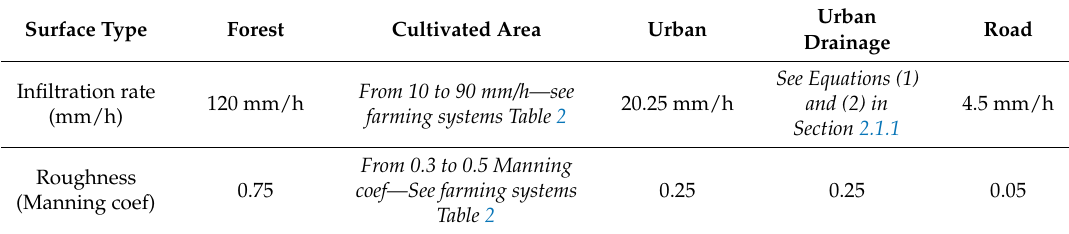
Table A1. Types of terrain surfaces with associated infiltration rate and roughness